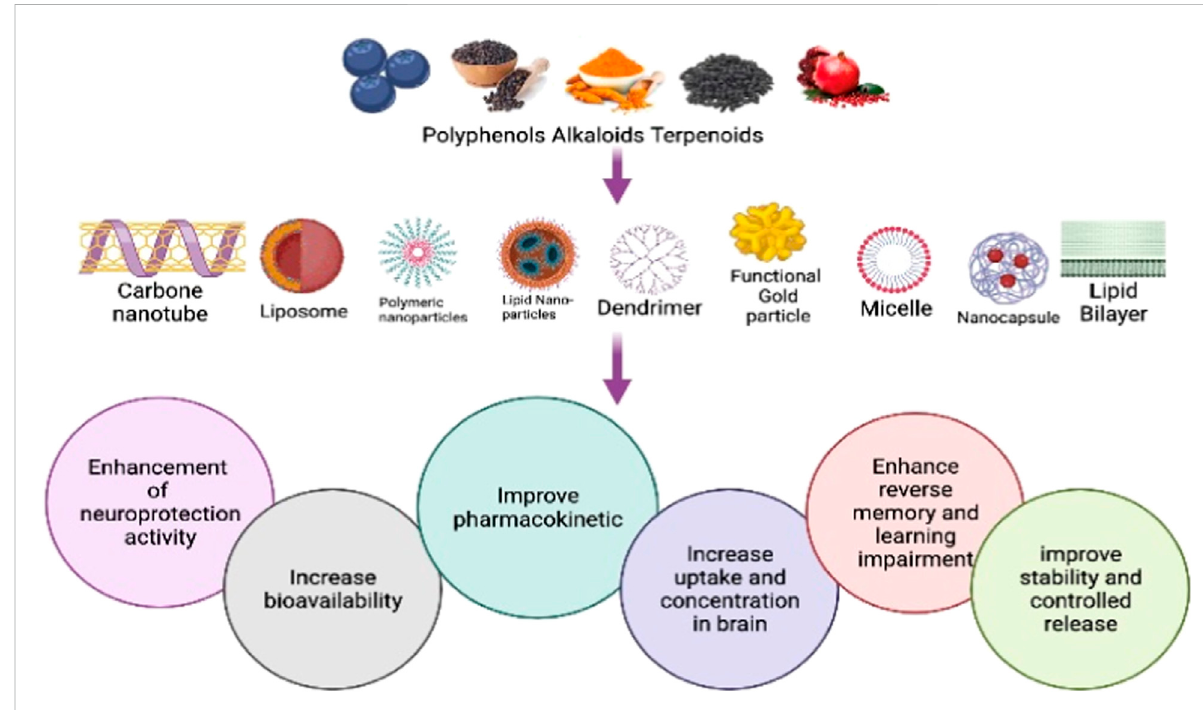
FIGURE 5 Nano-formulations are used to increase the potency of natural